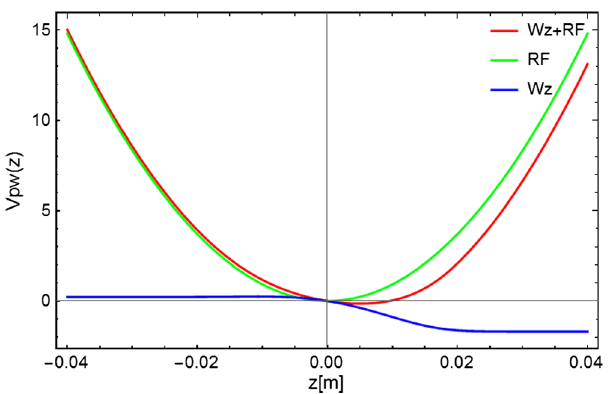
Q ¼ 10 . Figure 1 shows each potential term of Eq. (5) [15] used in the paper are listed in Table I.